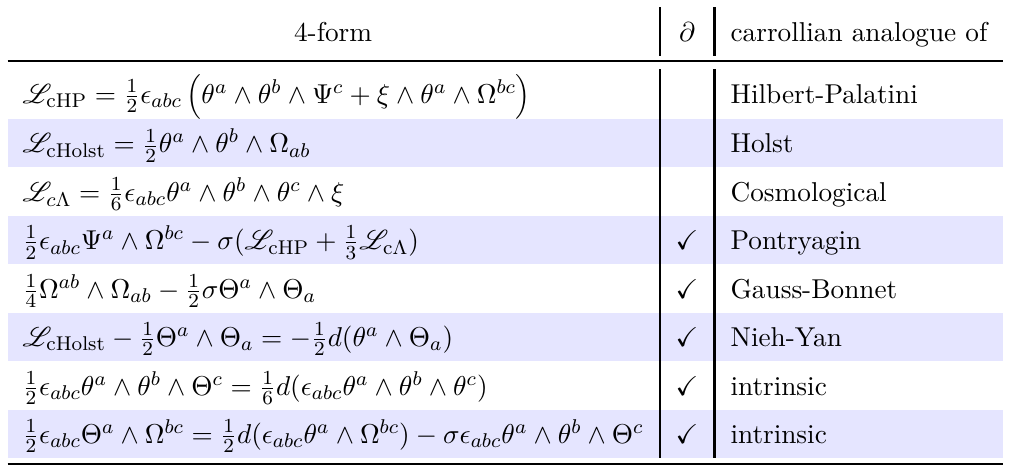
Table 1 . Summary of carrollian gauge-invariant 4 -forms and boundary terms ( ∂ ) for AdSC ( σ = +1 ), dSC ( σ = − 1 ) and C ( σ = 0 ). The carrollian curvatures are given by Ω ab = dω ab + ω a c ∧ ω cb + σθ a ∧ θ b and Ψ a = dψ a + ω a b ∧ ψ b + σξ ∧ θ a and part of the carrollian torsion is given by Θ a = dθ a + ω a b ∧ θ b .